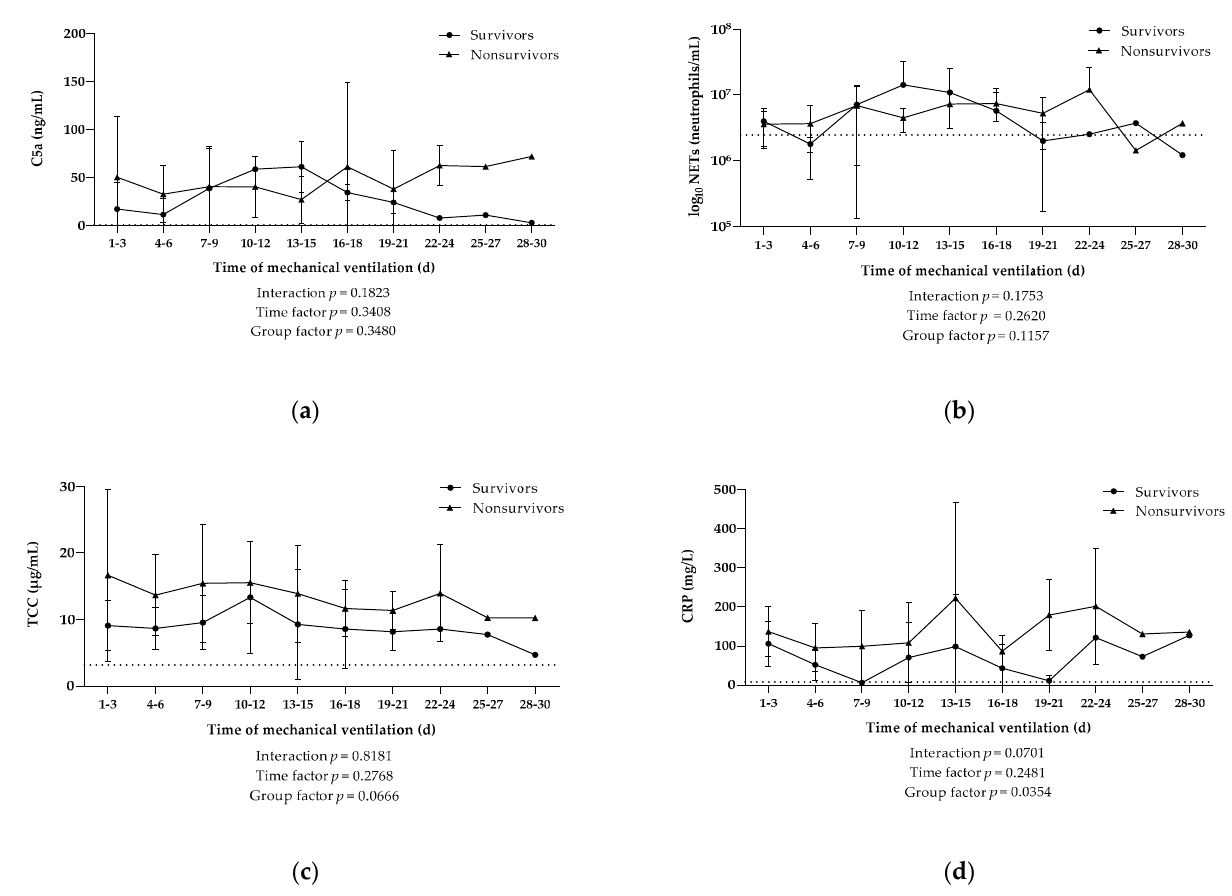
Figure 2. Kinetics of systemic activation of different parameters in blood. Levels of ( a ) complement protein C5a, ( b ) neu- trophilic extracellular traps (NETs), ( c ) terminal complement complex (TCC), and ( d ) CRP were measured during the course of mechanical ventilation of COVID-19 patients that survived ( n = 5) or died ( n = 7). Data are shown as mean ± SD. Dotted lines indicate the mean value in the control group. p -Values were calculated by linear mixed model of clustered log-transformed